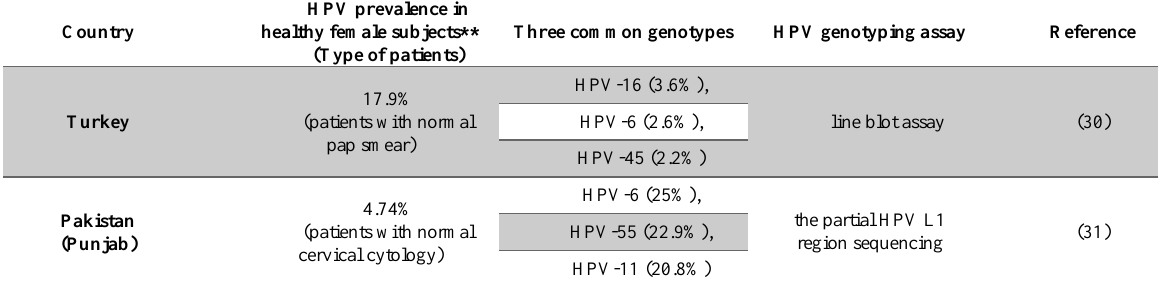
Table 6. HPV prevalence and three common genotypes of noncancerous cervical samples in Iran’s neighbouring countries*